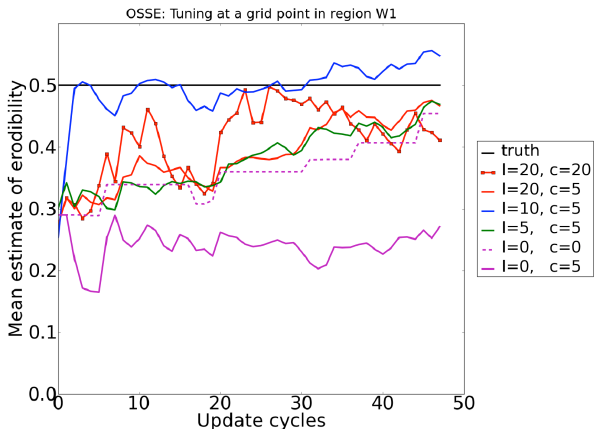
Fig. 7. Comparison between tuning for different values of l and c at a particular point. This point is marked x in the W1 area in Fig. 4. The evolution of the correlation function at this point is shown in Figure 7 : Comparison between tuning for different values of l and c at Fig. 6. a particular point. This point is marked x in the W1 area in Figure 4. The evolution of the correlation function at this point is shown in Figure 6. scale. However, the linear signal due to advection survives only over a length scale of l = 5 grid points. Various other experiments with different values of l and c are run to further investigate the interplay between cor- relation length and cutoff radius. The red and blue curves correspond to experiments with correlation length scales l = 20 and l = 10 (800 km), respectively. The behavior of the red (circles) curve ( l = 20, c = 10) is similar to that of